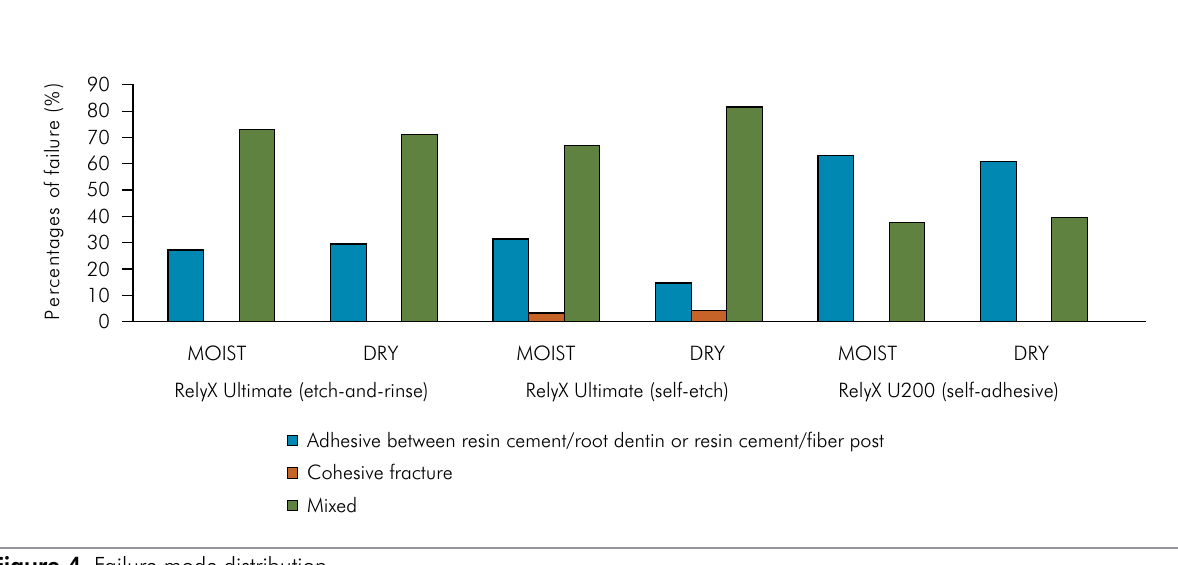
Figure 4. Failure mode distribution.